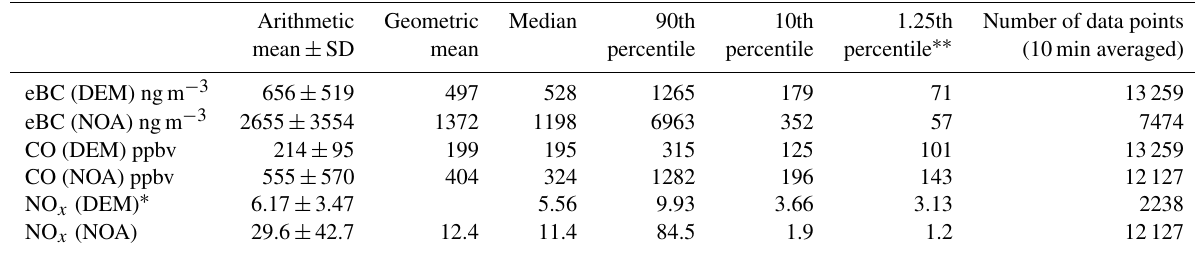
Table 1. Statistical summary of eBC and CO concentrations at DEM and NOA stations for the period between 6th December 2014 and 10th March 2015. Arithmetic Geometric Median 90th 10th 1.25th Number of data points percentile percentile percentile ∗∗ (10min